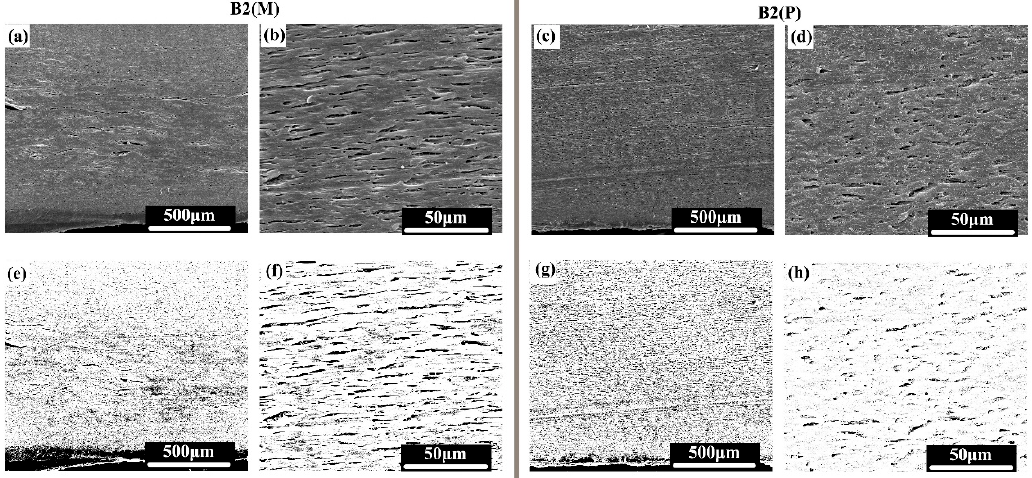
Figure 10. Phase morphology of the immiscible blend. The first row presents the original SEM photo, whereas the second row shows the modified picture for clear observation. Flow direction is horizontal. ( a , b , e , f ) Phase morphology of B2(M); and ( c , d , g , h ) phase morphology of